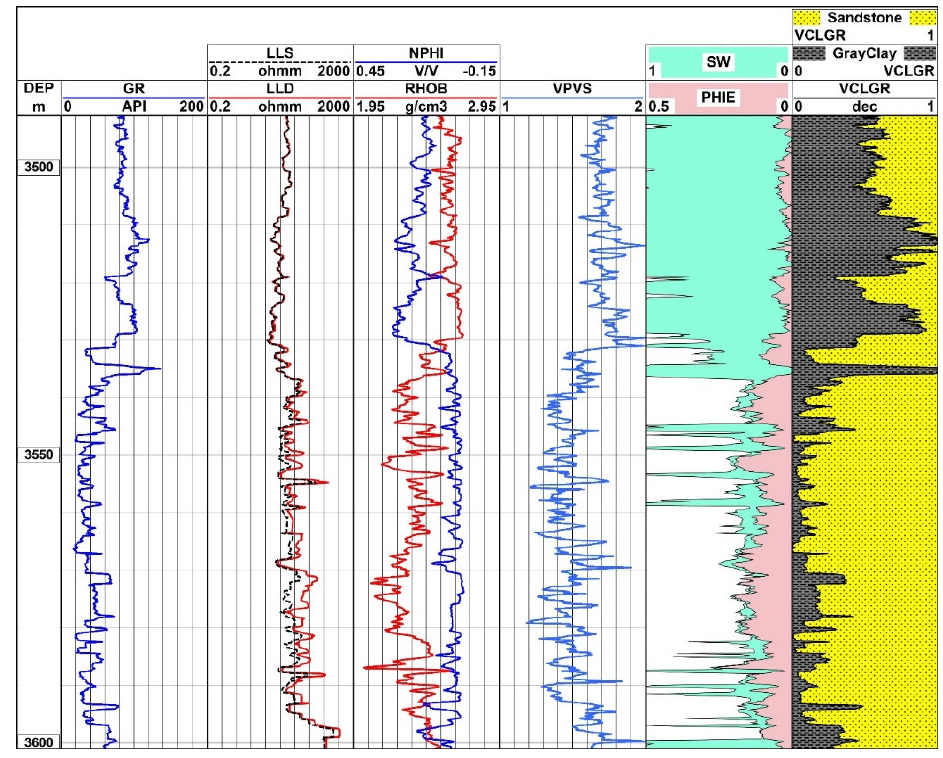
Figure 5. Well log data from Rehmat-02 well at gas zone. The reservoir zone is within the Lower Goru sand formation. Table 1. Prediction of petrophysical parameters from chosen depth intervals of two wells in the Middle Indus Basin.